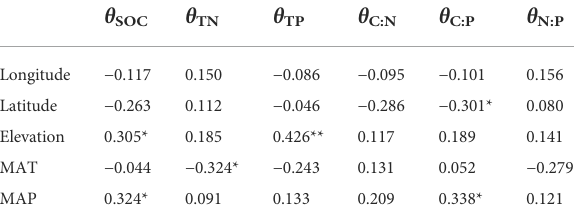
TABLE 3 Correlation relationships between the change rate of nutrient concentrations and stoichiometric ratios against geographic and climatic variables. * and ** represent p < 0.05 and p < 0.01,